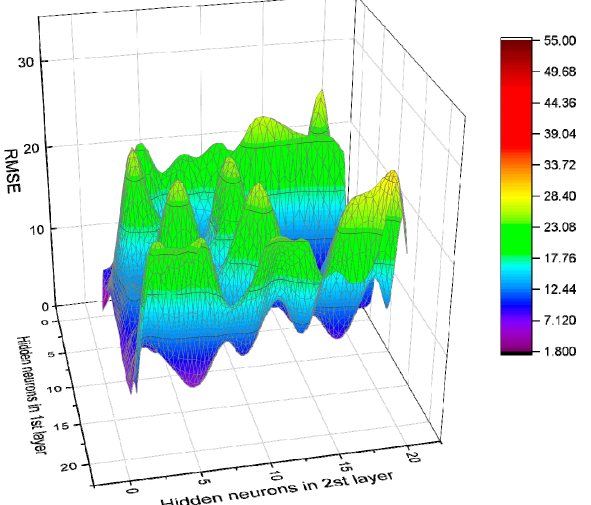
Figure 20. RMSE value of BPNN model based on Log-Sigmoid (double hidden layers).